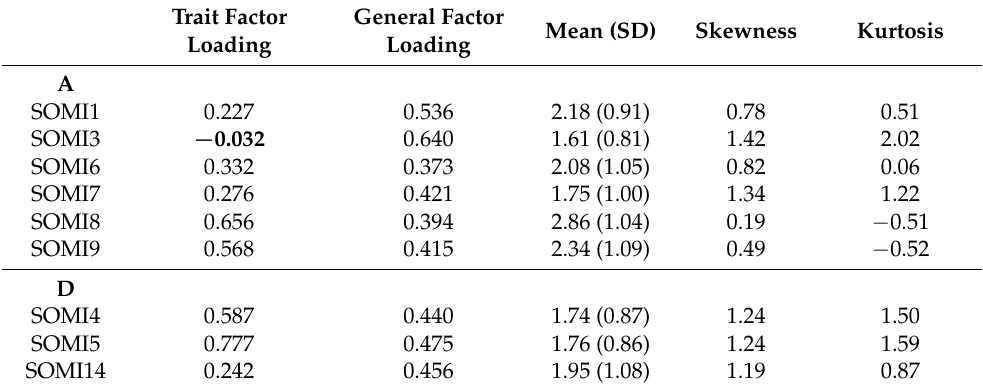
Table 2. Item properties of the Sexual Orientation Microaggression Inventory